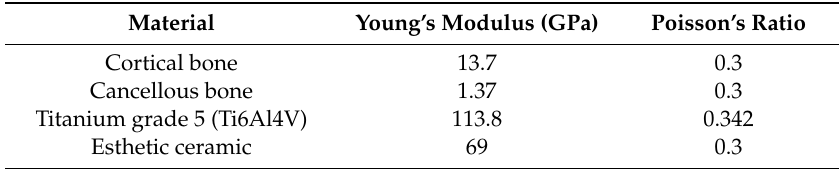
Table 1. Mechanical properties of all materials used.